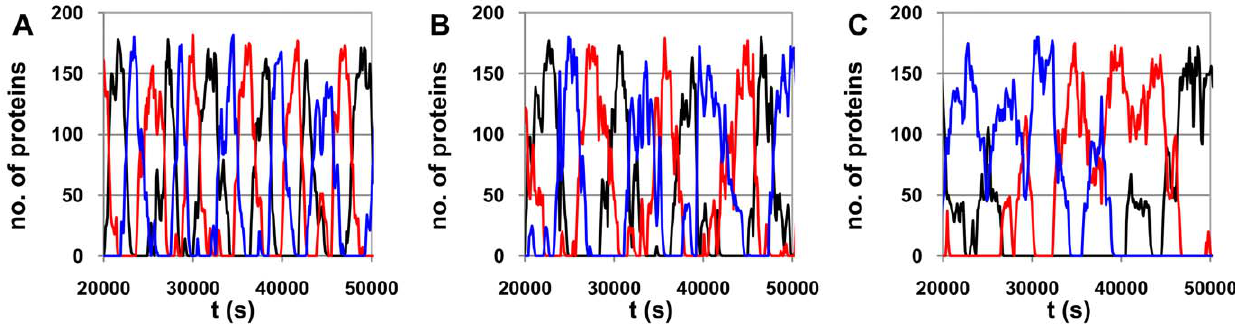
Figure 7. Dynamical effects of pauses on the repressilator dynamics. Sample of the time series of the 3 proteins (P i=1,2,3 ) of the repressilator from t=20000 to 50000 s (sampling frequency of 1 s) for (A) k pause =0.55 s 2 1 and d pause =3 s, (B) k pause =10 s 2 1 and d pause =3 s, and (C) k pause =0.55 s 2 1 and d pause =100 s. Black line is P 1 , red line is P 2 , and blue line is P 3 .